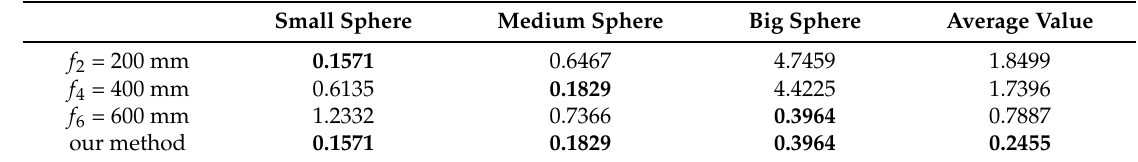
Table 2. Data comparison of fitting results in terms of RMSE (mm).